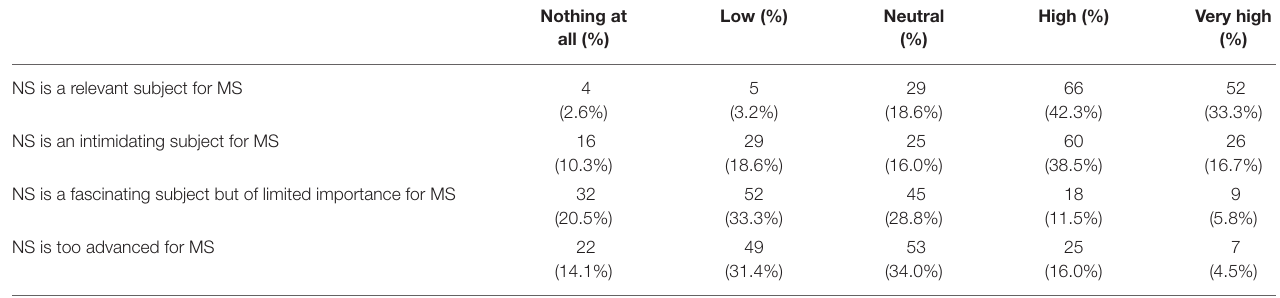
TABLE 3 | Importance of neurosurgery in medical school.